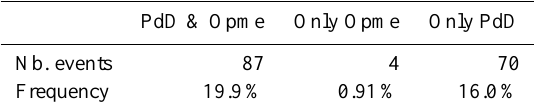
Table 3. Statistical data of nucleation event occurrences.